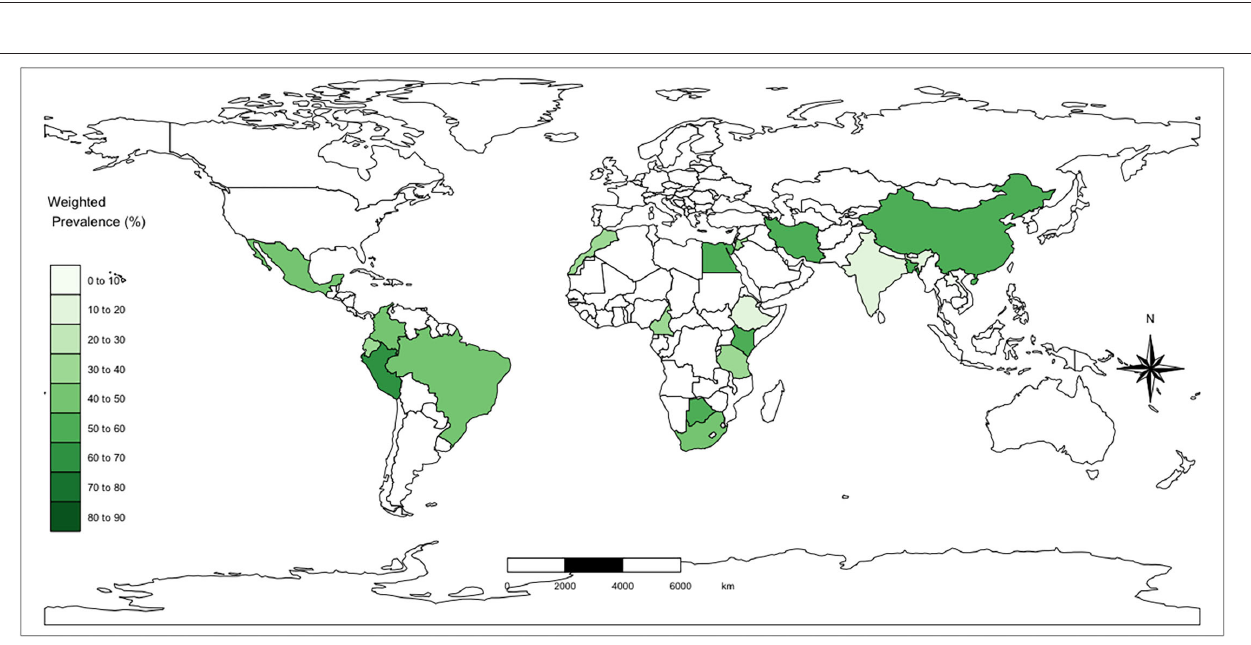
Frontiers in Veterinary Science |